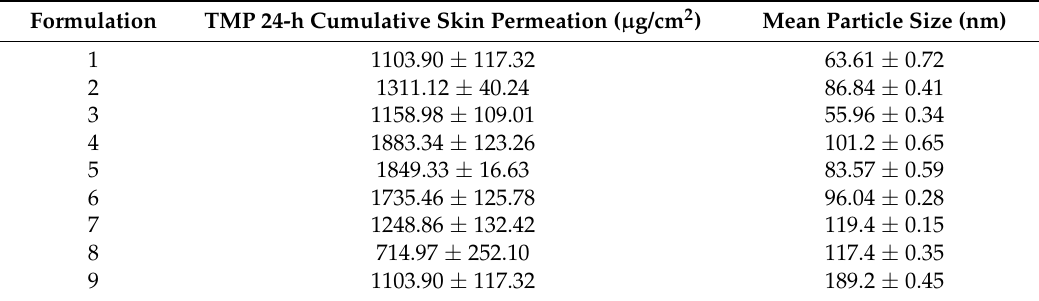
Table 1. Characteristics of TMP-ME formulations.